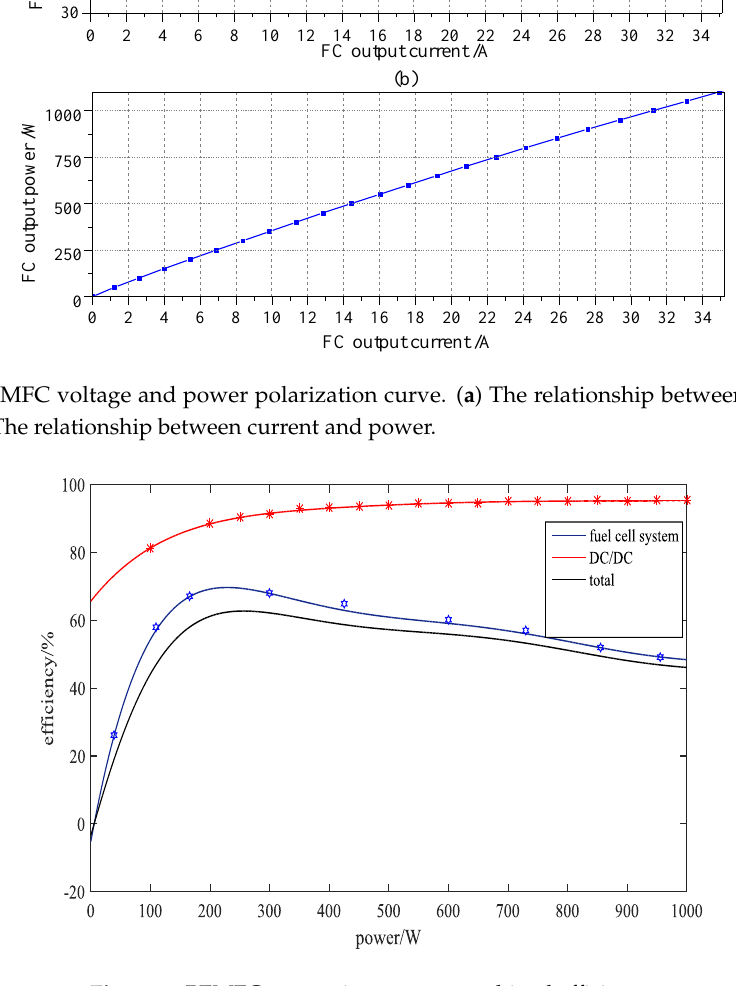
Figure 5. PEMFC generation system combined efficiency.